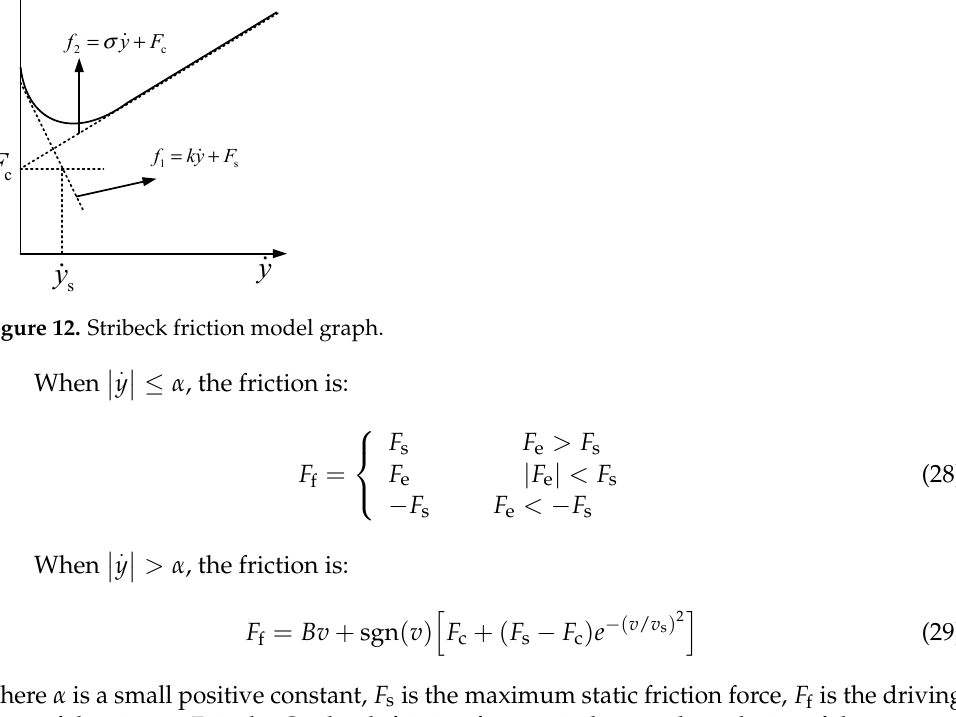
f and the frictional force 2 F . The straight line C